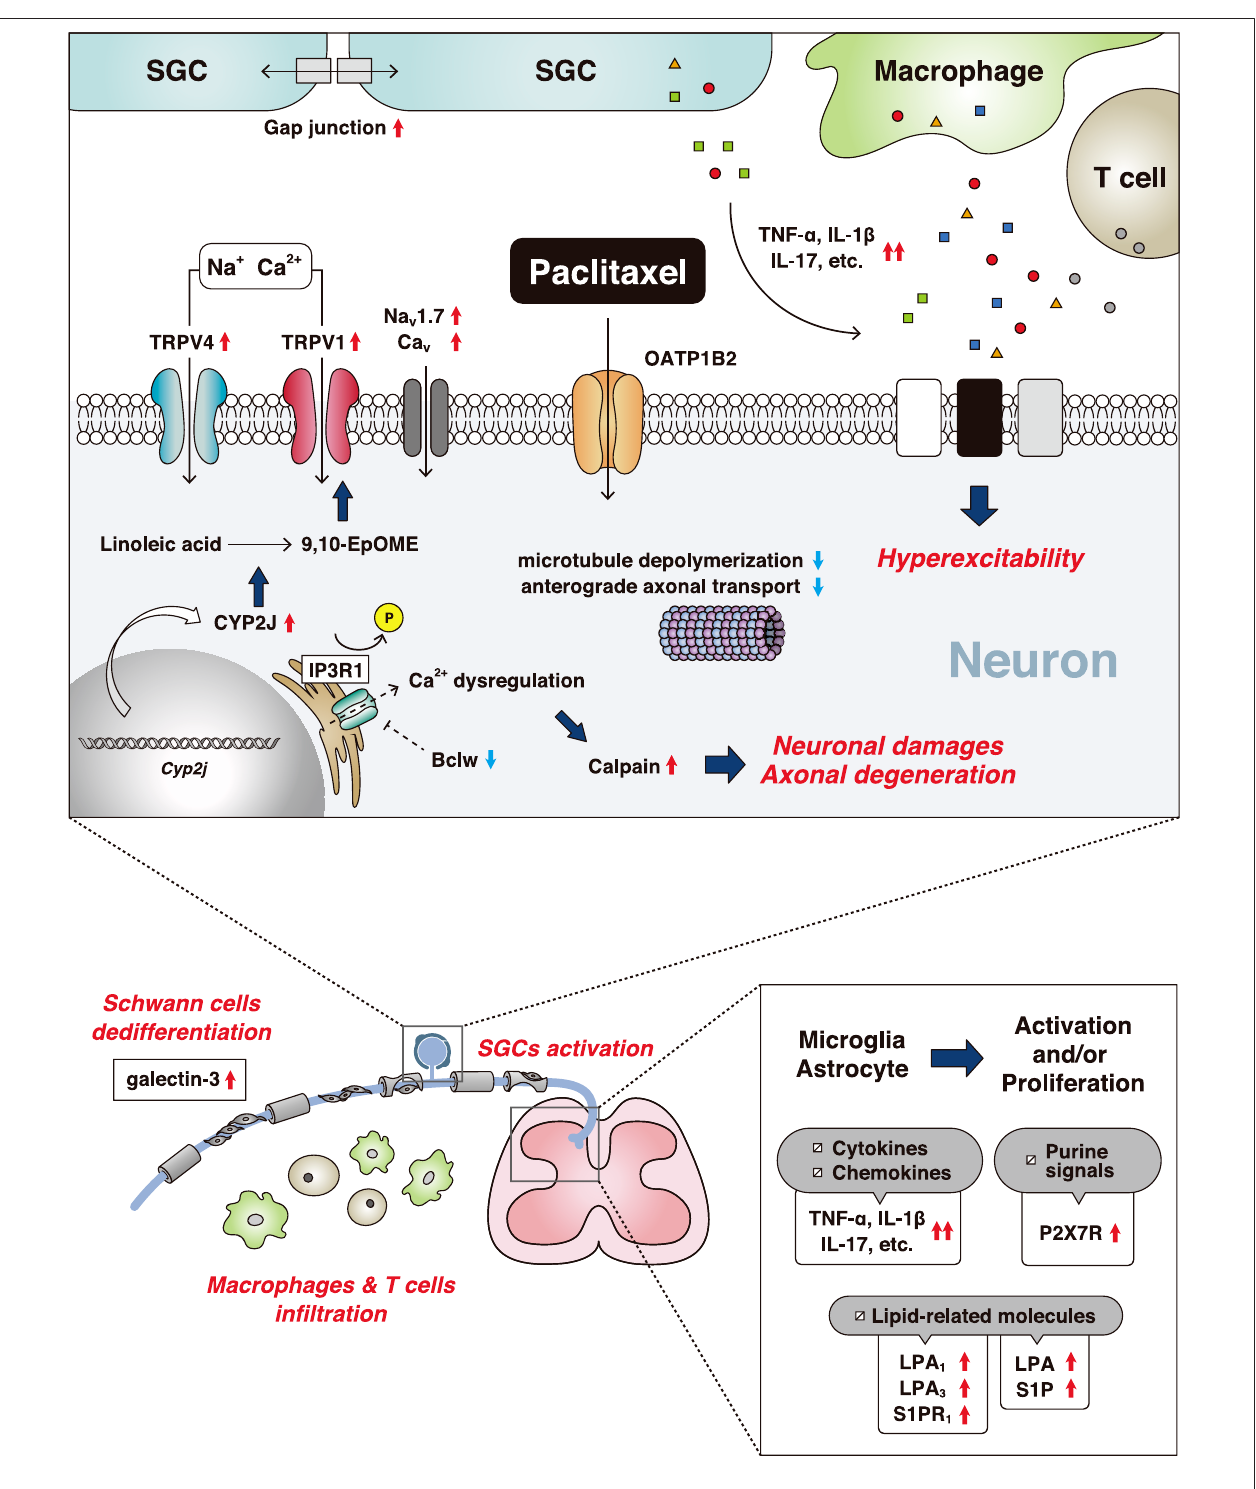
FIGURE2| Mechanismsofpaclitaxel-inducedperipheralneuropathy.Thereduparrowsindicateanincreaseand/oractivationandthebluedownarrowsindicatea decrease and/or inhibition. Abbreviations: 9,10-epoxy-12Z-octadecenoic acid (9,10-EpOME); bcl-2-like protein 2 (Bclw); voltage-gated calcium channel (Cav); cytochrome-P450-epoxygenase2J(CYP2J);interleukin(IL);inositol1,4,5-trisphosphatereceptor1(IP3R1);lysophosphatidicacid(LPA);voltage-gatedsodiumchannel (Nav); organic anion-transporting polypeptide B2 (OATP1B2); P2X purinoceptor 7 (P2X7R); sphingosine 1-phosphate (S1P); satellite glial cell (SGC); tumor necrosis factor (TNF); transient receptor potential channel (TRP).